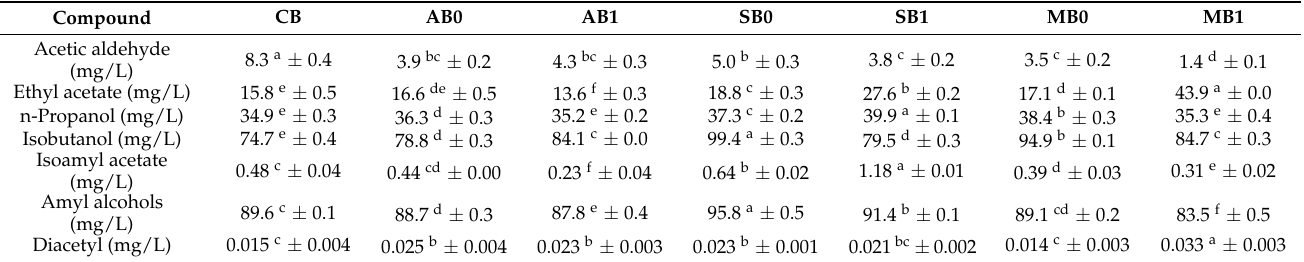
Table 2. Contents of volatile organic compounds in beers with addition of the Saskatoon fruit.